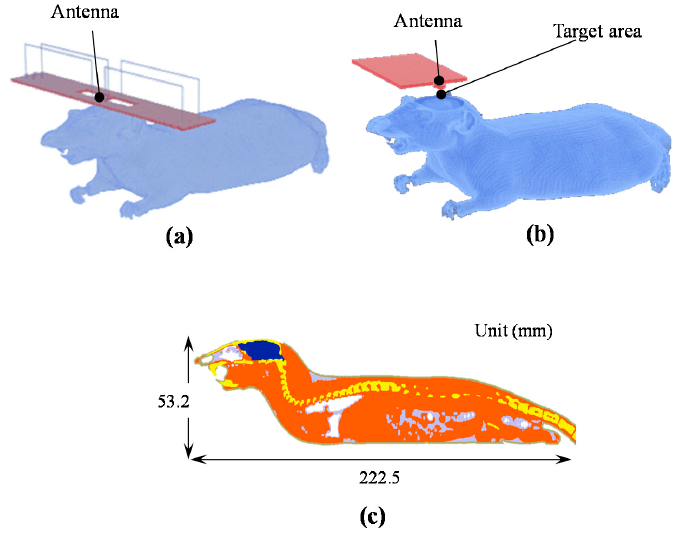
Figure 1. Position of the rat and antennas during exposure: ( a ) the antennas correspond to a figure-8 loop antenna for a 1.5 GHz exposure; ( b ) monopole-fed antenna for 6 and 10 GHz exposure; and ( c ) the cross section and size of the numerical rat